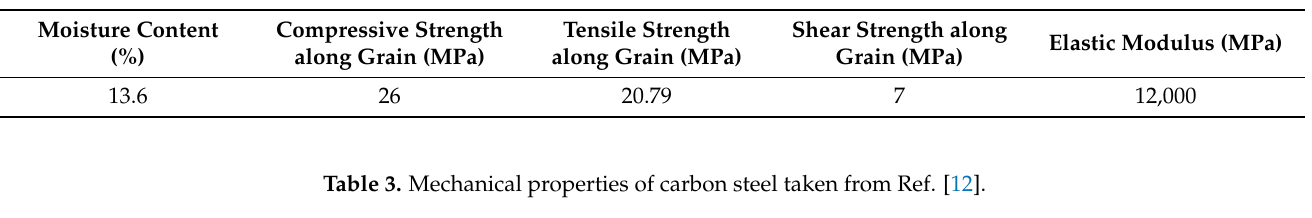
Table 2. Mechanical properties of Northeast larch timber taken from Refs. [14–16].